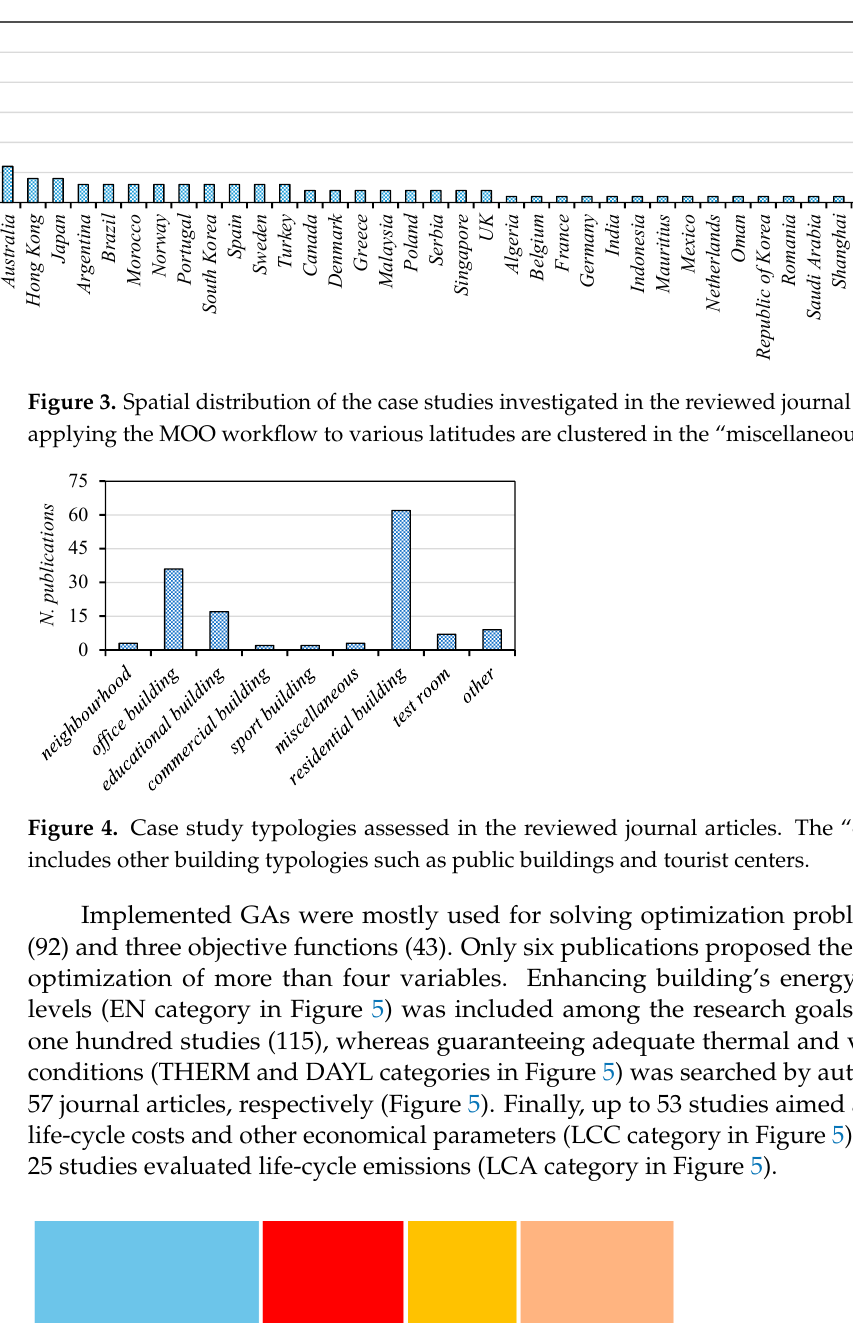
Figure 5. Objective functions evaluated in the reviewed journal articles. A larger area corresponds to a higher number of works that optimized that function.